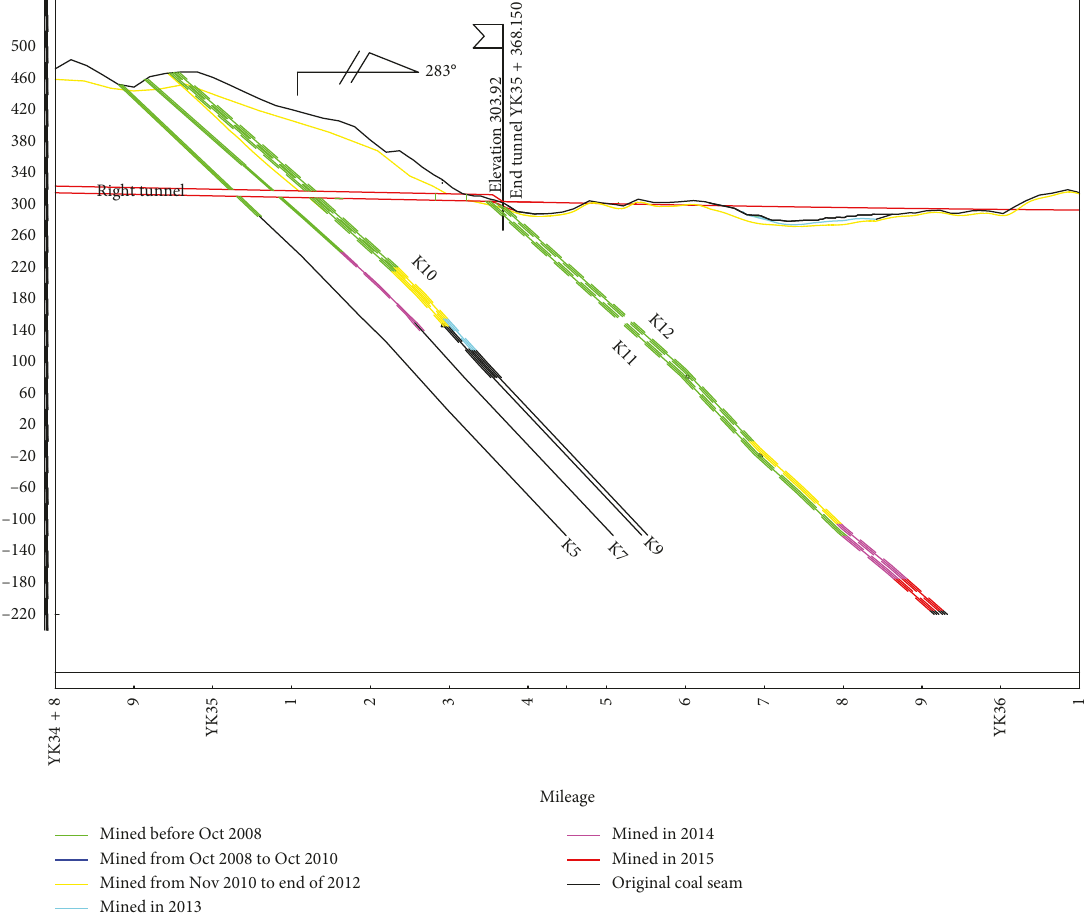
Figure 5: Section of right